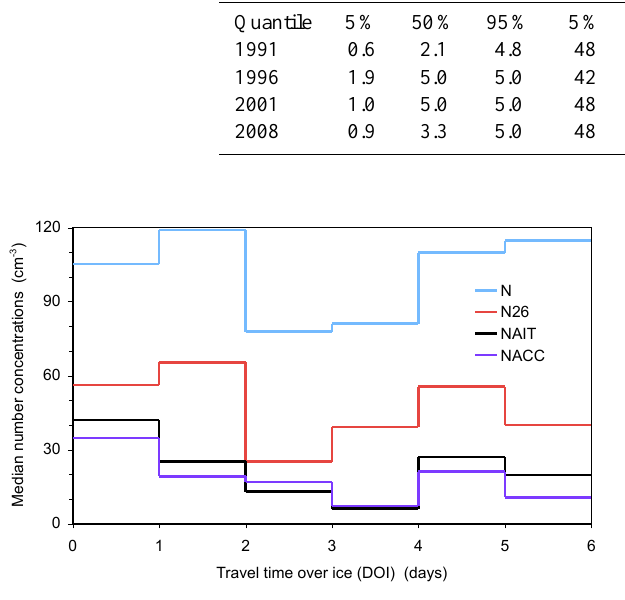
Fig. 10. Median total number (N, cm − 3 ), number concentration below 26nm particle diameter (N26, cm − 3 ), number concentra- tion (NAIT, cm − 3 ) between 26nm and Hoppel diameter DHO, and number concentration between DHO and 600nm (NACC, cm − 3 ) as a function of travel time over ice (DOI, days). Data for all travel times of five days and longer have been collected in the column 5–6